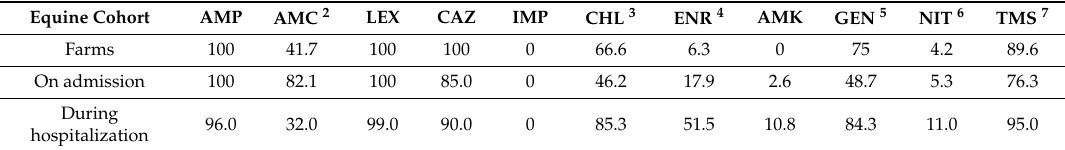
Table 3. Antibiotic 1 resistance rates (percentage) of ESBL-E isolates shed by farm horses, horses on admission, and hospitalized